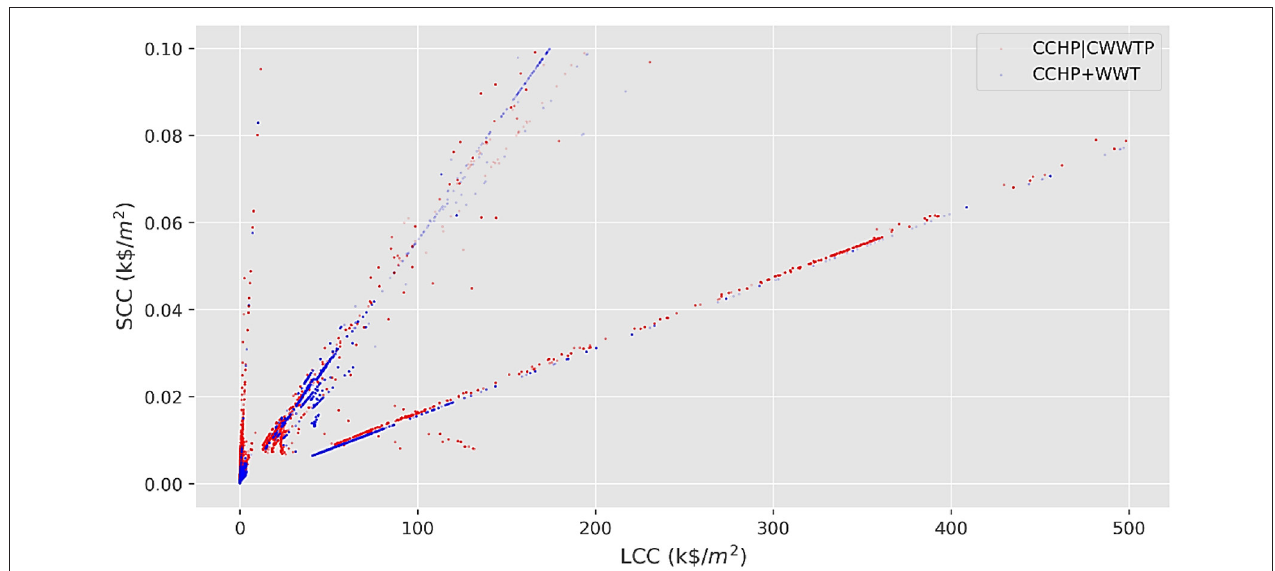
FIGURE 4 | Life-cycle social cost of carbon vs. life-cycle cost of equipment for the individual neighborhoods (single dots on the plot), with SCCs less than 0.1 k$/m 2 , generated by the optimization algorithm for the analyzed scenarios. Neighborhoods generated in later generations by the Genetic Algorithm are shown more opaque than the earlier generations (Red dots: conventional design, blue dots: integrated